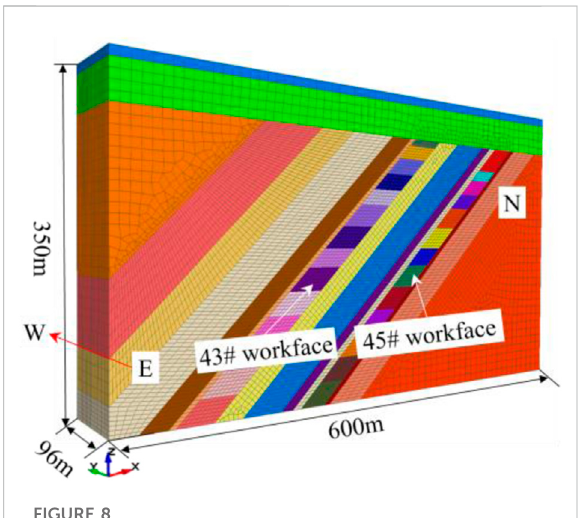
FIGURE 8 Numerical calculation model of Wudong Coal Mine North Mining